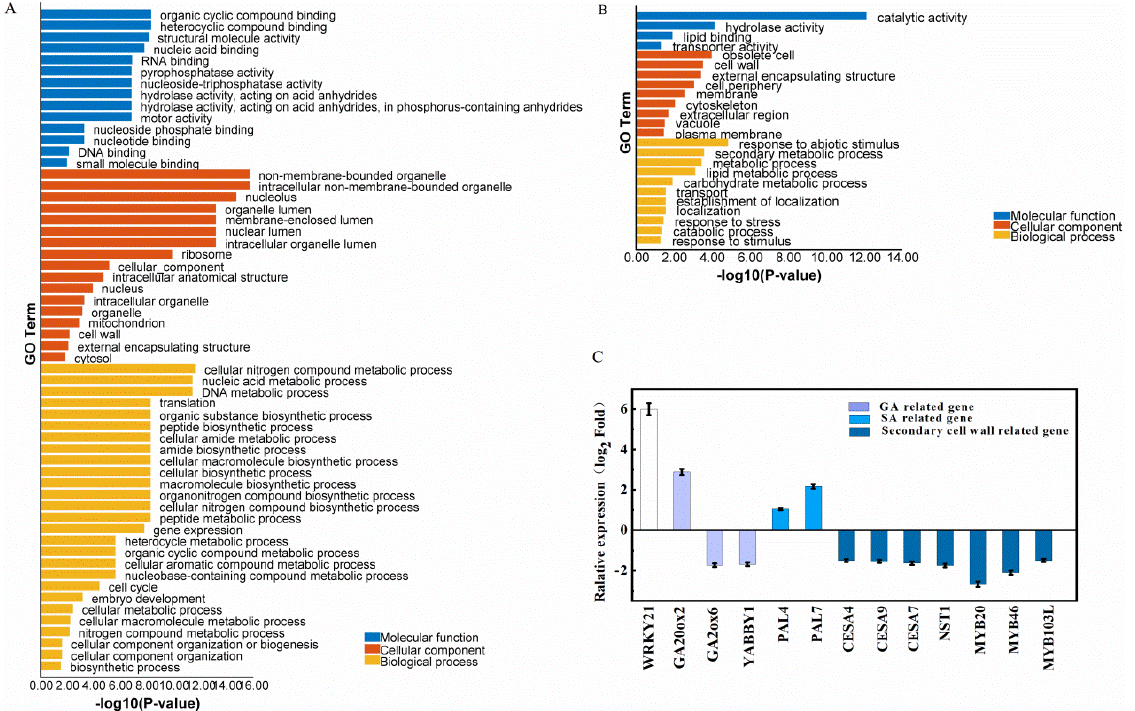
Figure 5. GO analysis of differentially expressed genes upregulated ( A ) or downregulated ( B ) in OsWRKY21 OE plants compared to wild–type ZH11; ( C ) the expression of the GA, SA metabolic genes and the typical secondary cell wall biosynthesis and regulatory genes.